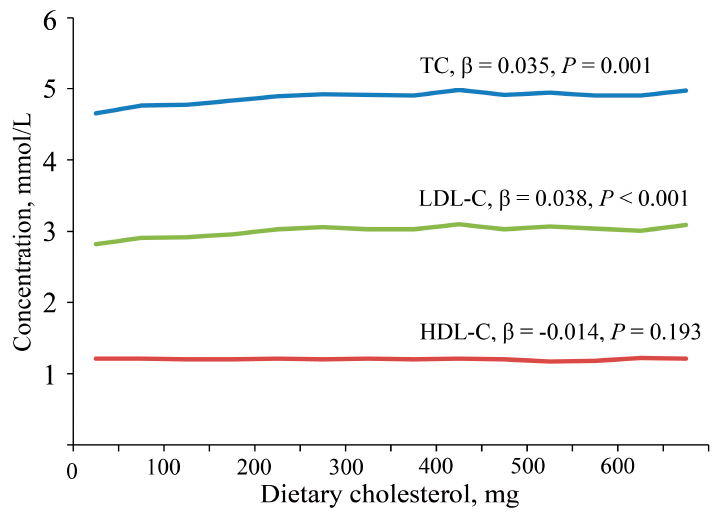
Figure 3. Relationship of dietary cholesterol and serum cholesterol levels. The graph represents the effect of a change in dietary cholesterol intake (per 100 mg) on serum total cholesterol (TC), low-density lipoprotein cholesterol (LDL-C), and high-density lipoprotein (HDL-C). Linear regression models were used to study the effect of dietary cholesterol on serum TC, LDL-C, and HDL-C. β represents Standardized Coefficients for per 100 mg dietary cholesterol intake.